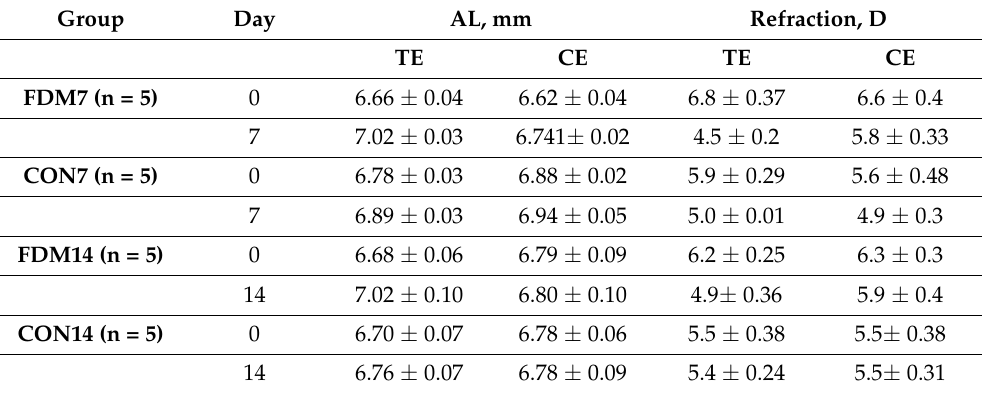
Table 1. Ocular biometrics and